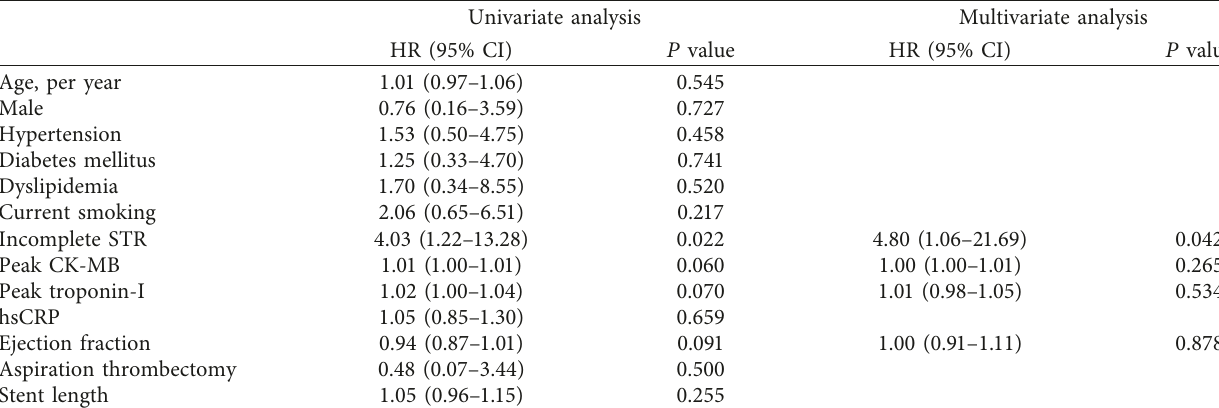
Table 3: Univariate and multivariate regression analyses for predicting high IMR (IMR